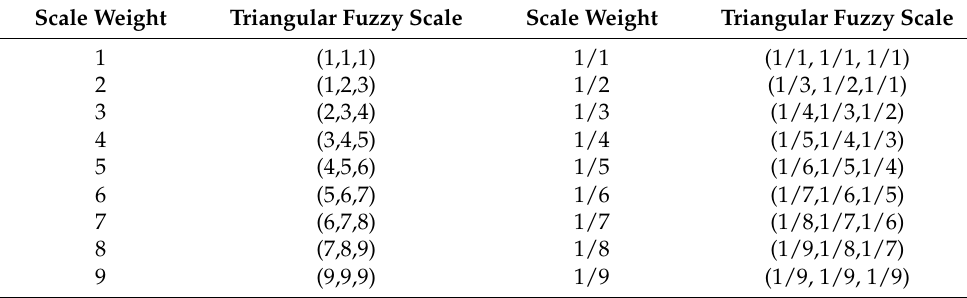
Table 3. AHP to fuzzy-AHP weight conversion table. Scale Weight Triangular Fuzzy